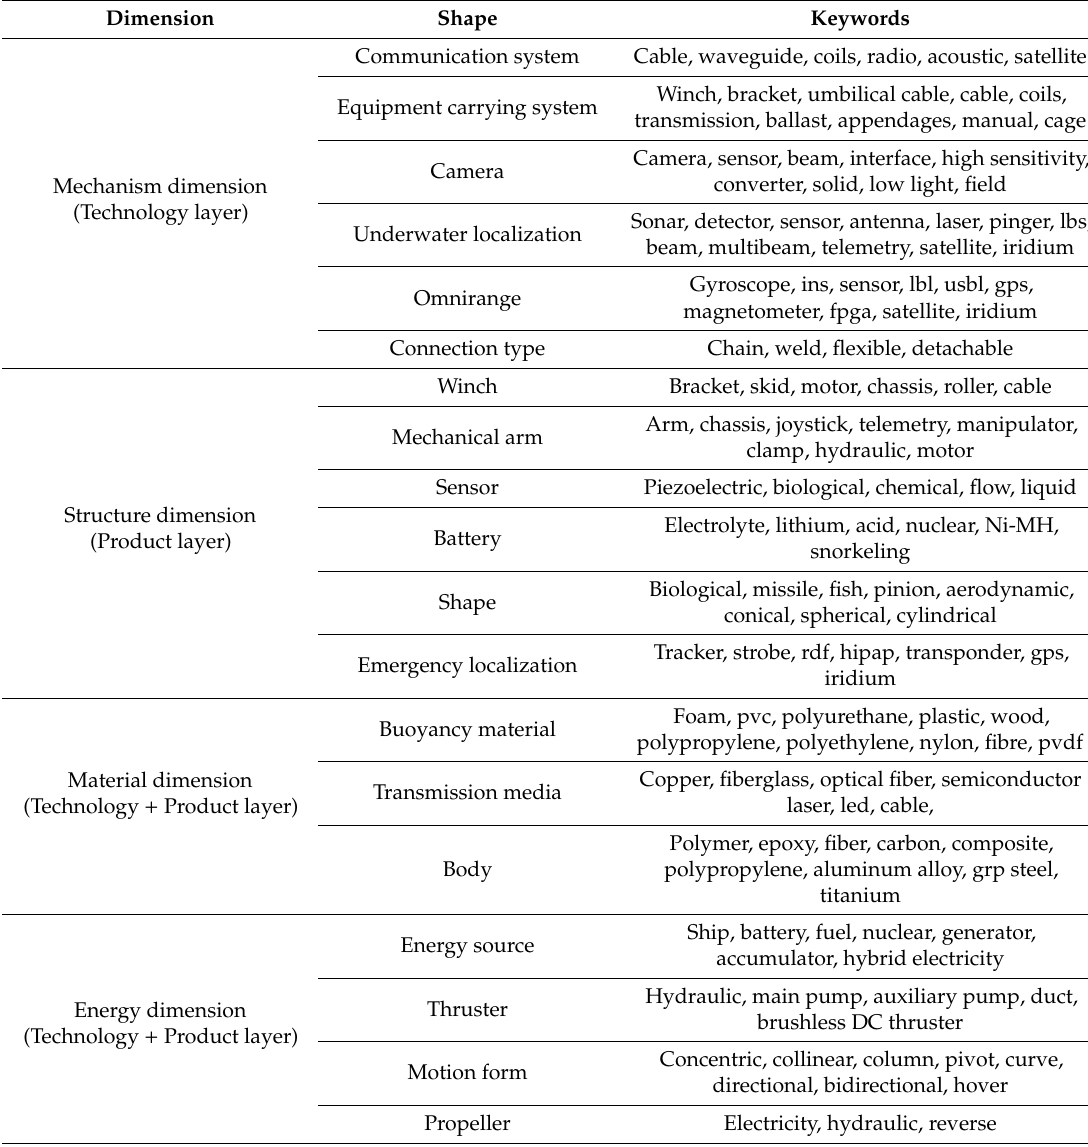
Table 4. Morphological matrix for the underwater vehicle